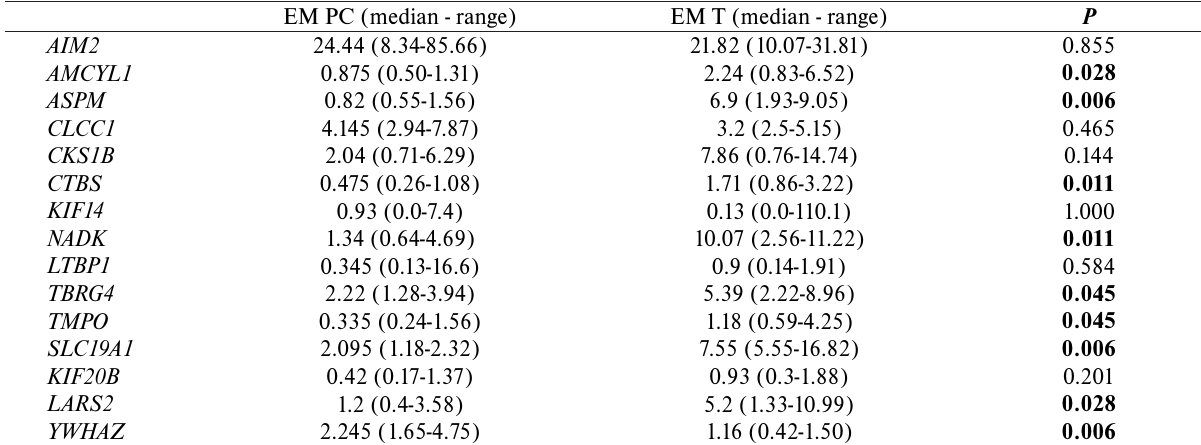
Table 3c. Comparison of gene expression between EM PC and EM T groups.